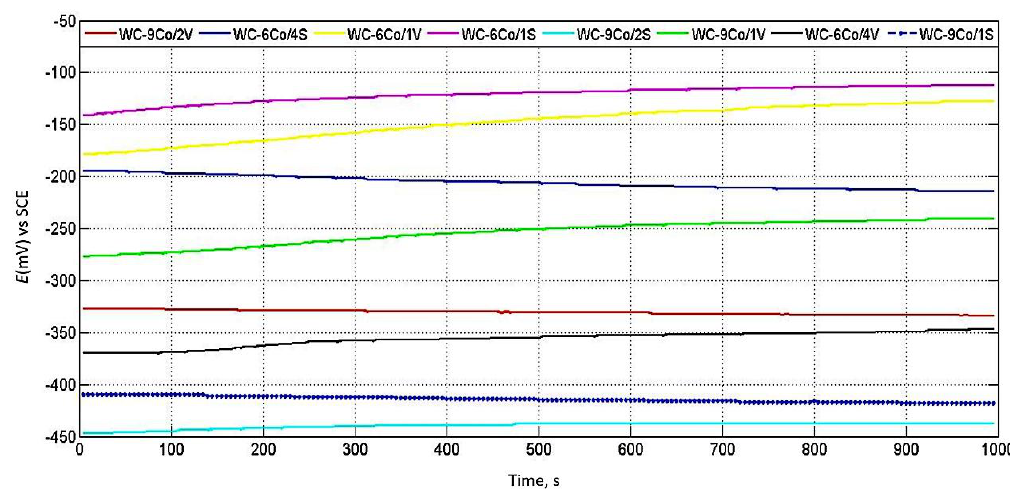
Figure 1. Corrosion potential E corr of samples.